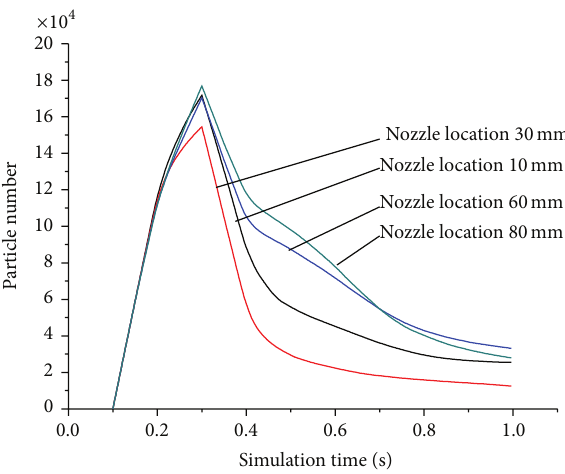
Figure 5: The number of remaining particles in 0.2 s feeding time.